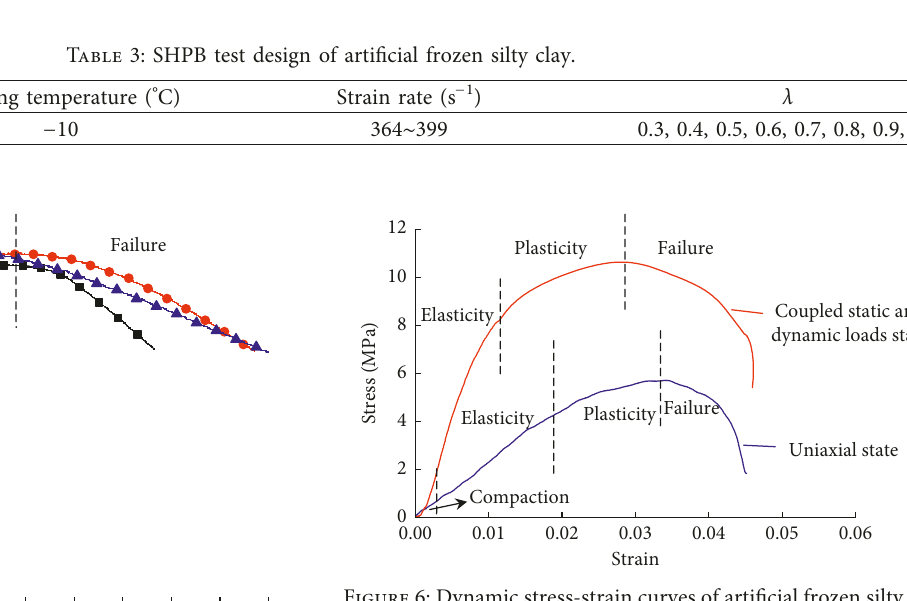
Figure 6: Dynamic stress-strain curves of artificial frozen silty clay at − 10 °